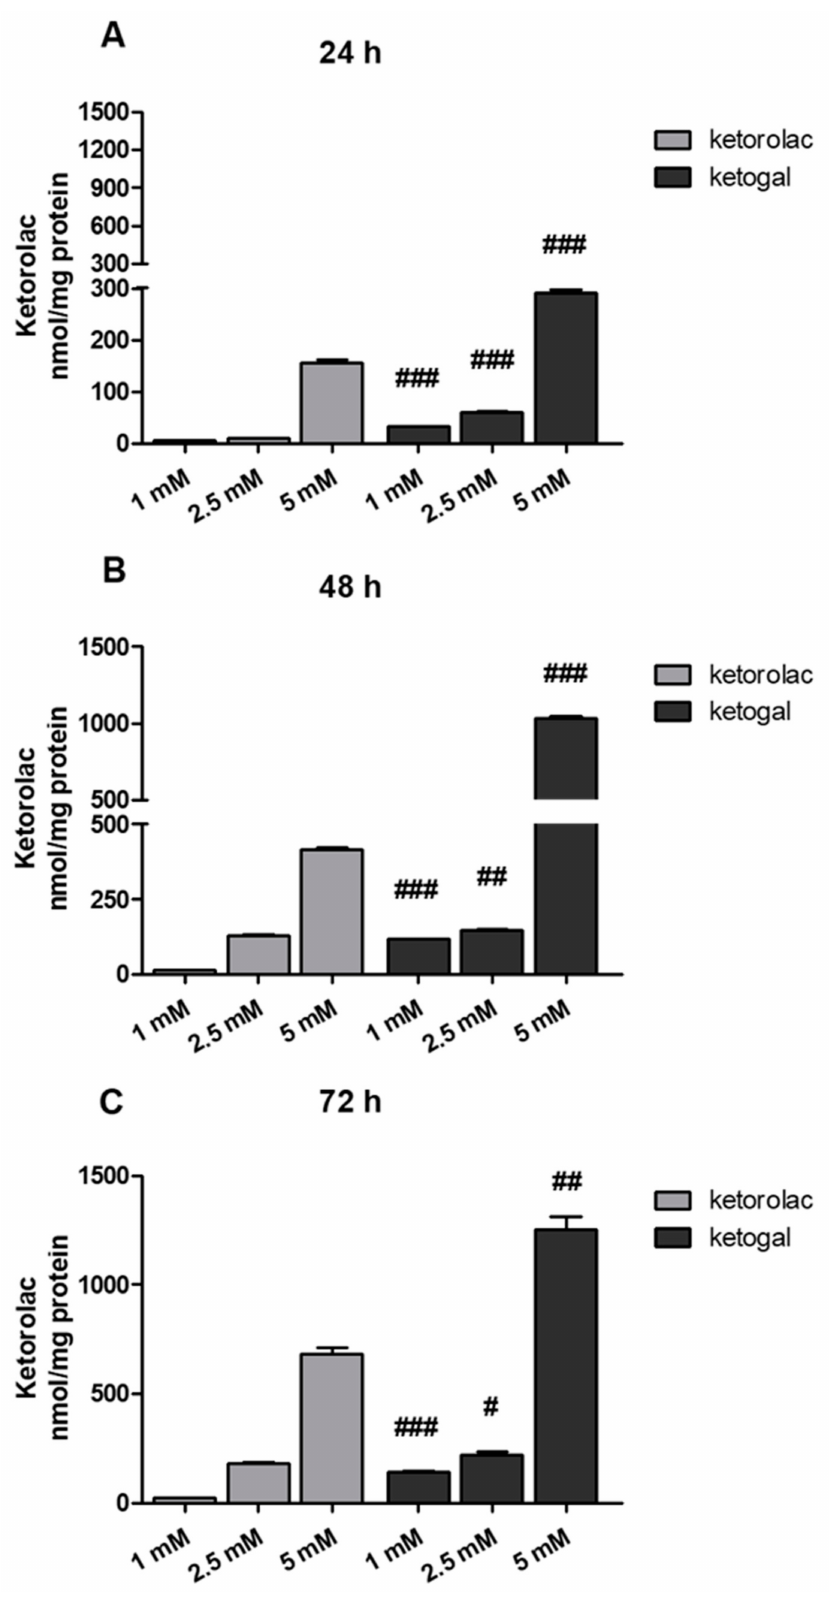
Figure 3. Amount of ketorolac in cell extracts of CoEpi cells incubated for 24 ( A ), 48 ( B ), or 72 ( C ) h in the presence of either 1, 2.5, or 5 mM ketorolac or ketogal. Data are presented as means ± SEM ( n = 3). Significance of ketogal vs. ketorolac: # p < 0.05; ## p < 0.01; ### p <